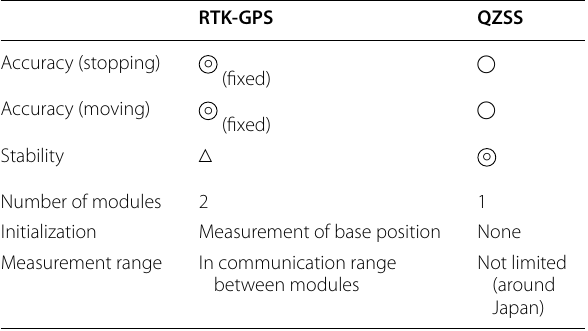
Table 4 Statistics of the RTK‑GPS and the QZSS